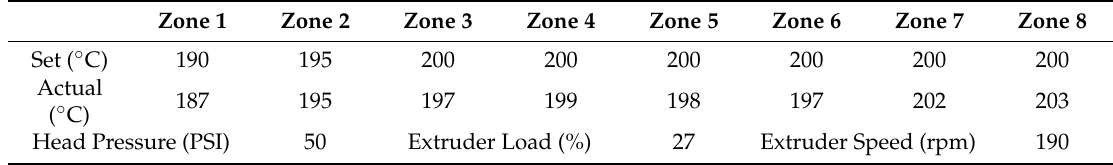
Figure 1. Chemical structure of ( a ) polypropylene (PP) and ( b ) styrene-(ethylene-butylene)-styrene (SEBS). Table 1. Extrusion process parameters of PP/SEBS blends.